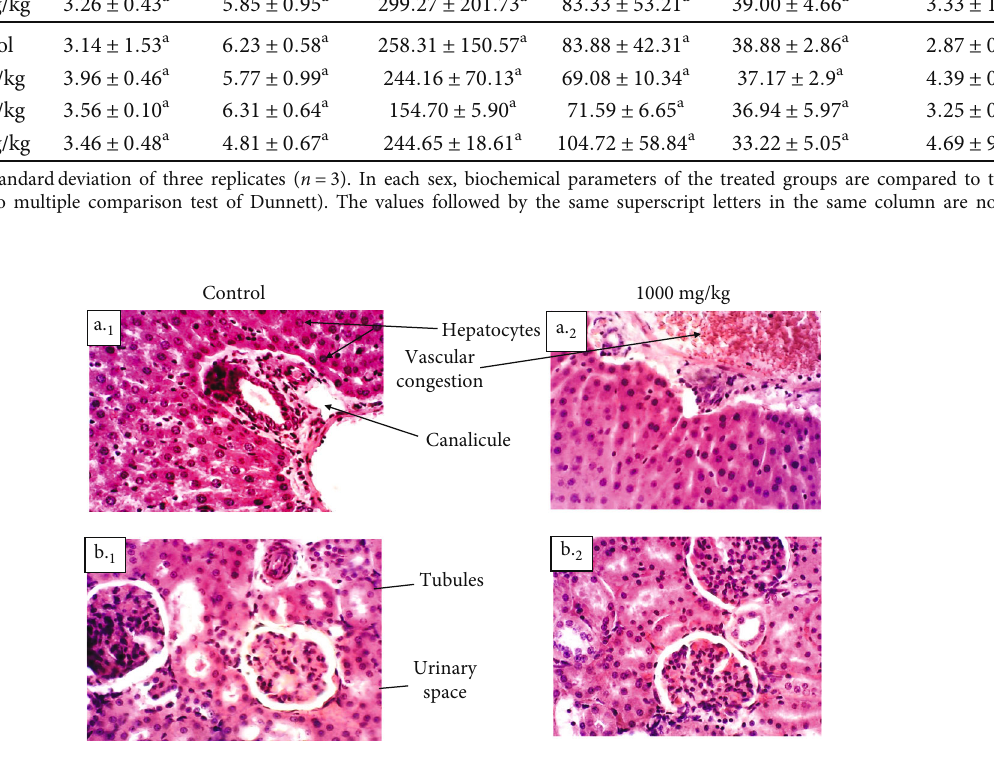
Figure 3: Photomicrographs of rats ’ liver (H&E, X200) and kidney (H&E, X200). Liver (a) : control group, (b) : treated group at 1000mg/kg) of male albino Wistar rats showing relatively kg); kidney histology (b) 1 2